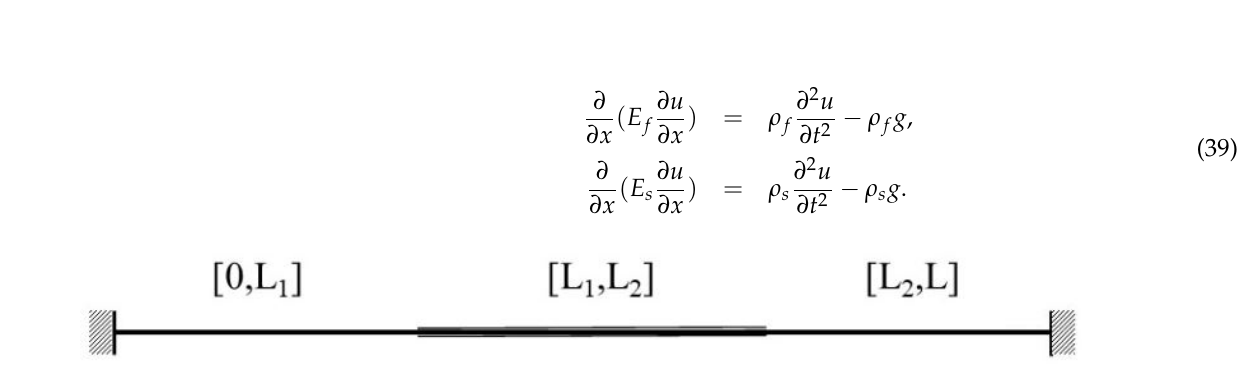
Figure 5. One-dimensional model problem of one continuum immersed in another